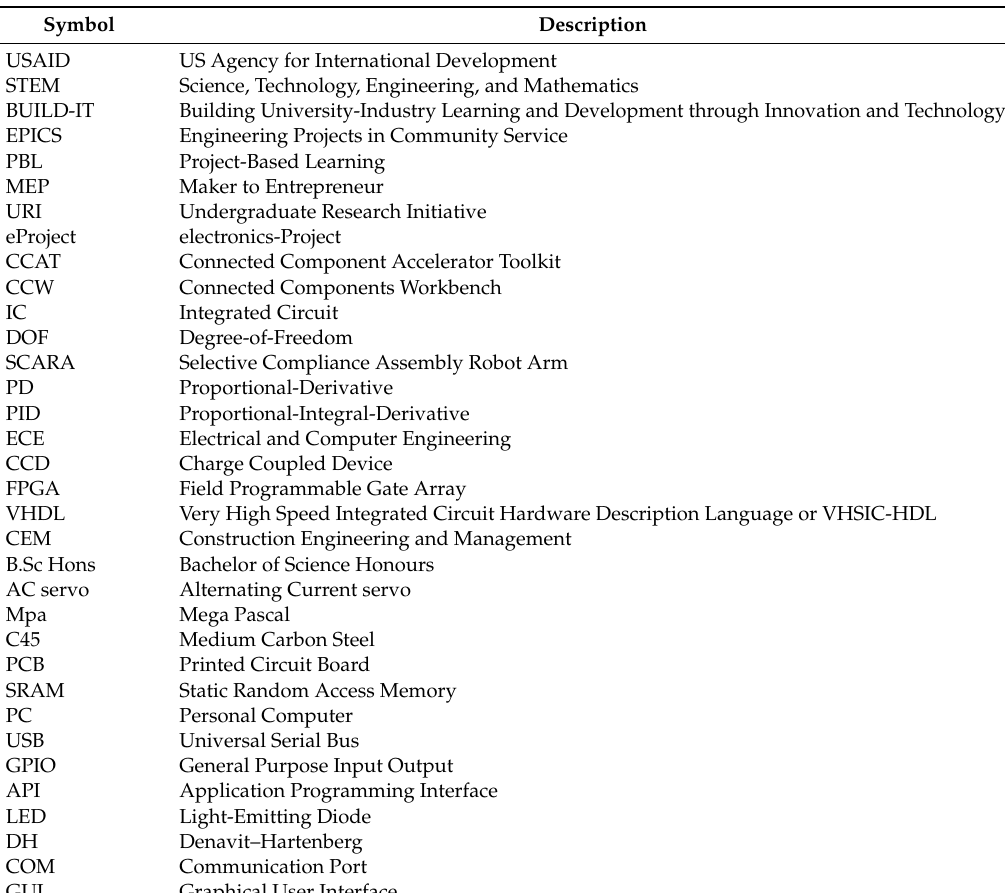
Table A1. List of